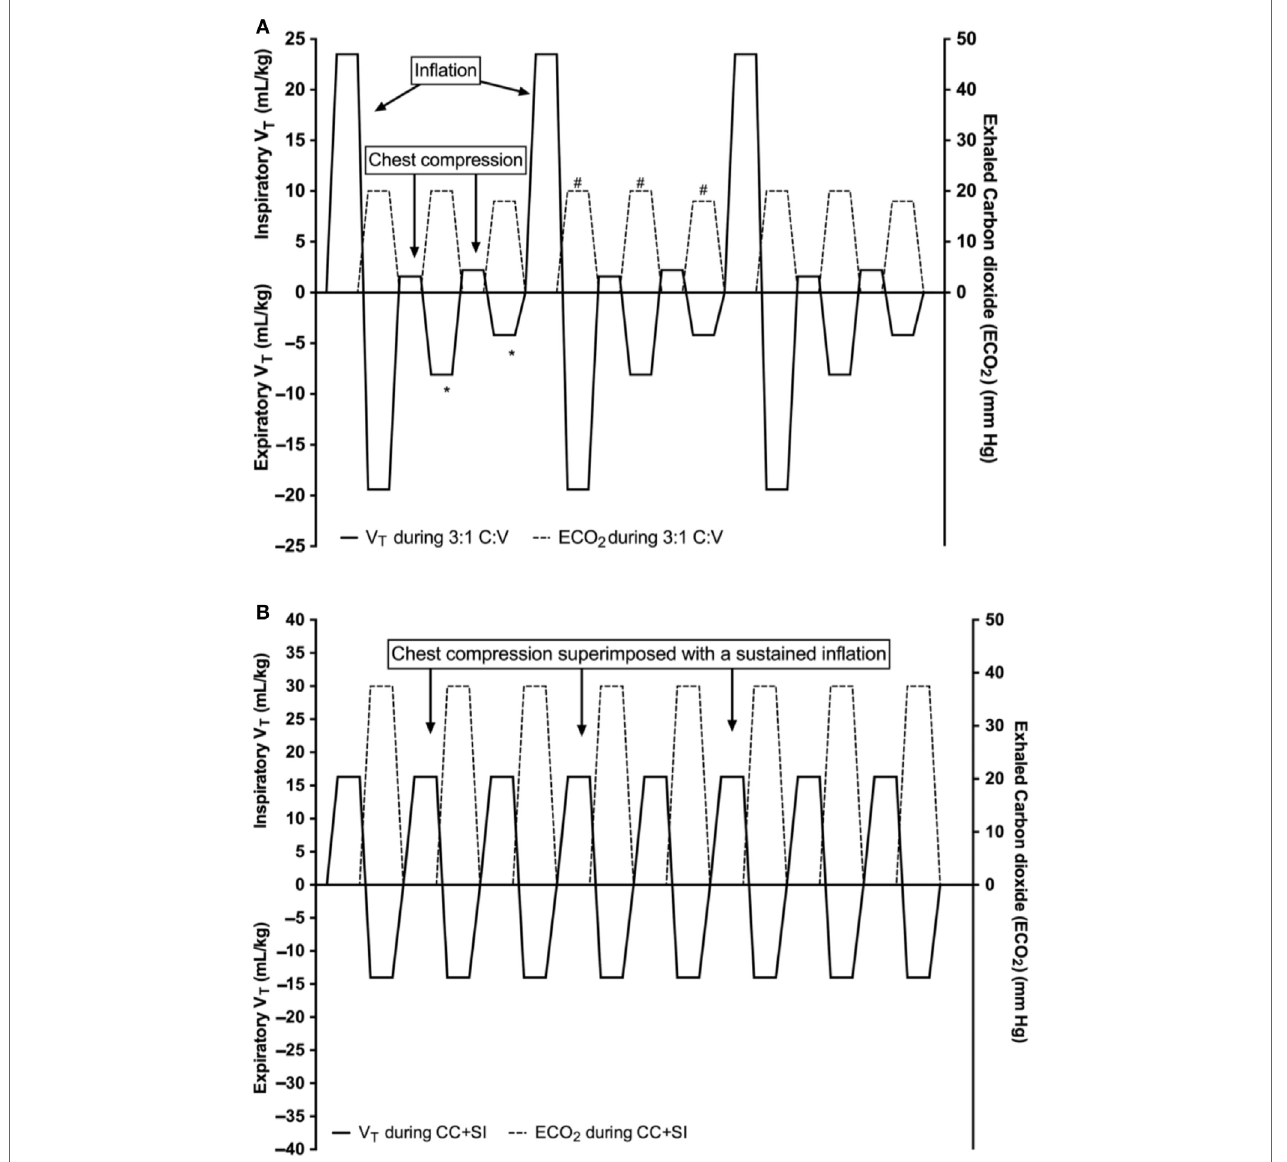
FiGURe 2 | Tidal volume (mL/kg) changes during 3:1 compression:ventilation ratio (3:1 C:V) (A) and continuous chest compressions (CCs) superimposed by sustained inflations (SIs) (CC + SI) (B) . Reproduced with permission from Li et al.